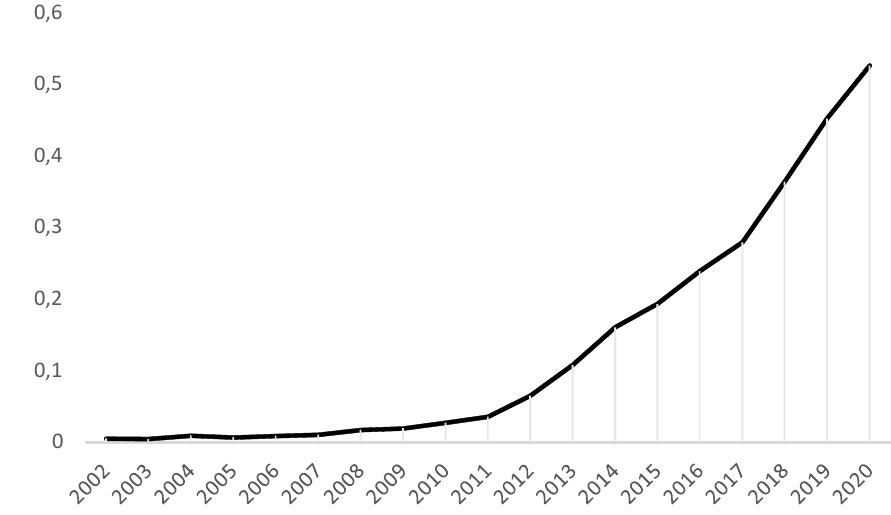
00,10,20,30,40,50,6 Figure 4. Ratio between the development levels of the payment card market and the development level of the non-financial sector of the Ukrainian economy Figure 5. Cross-correlation matrix of the studied parameters (financial and